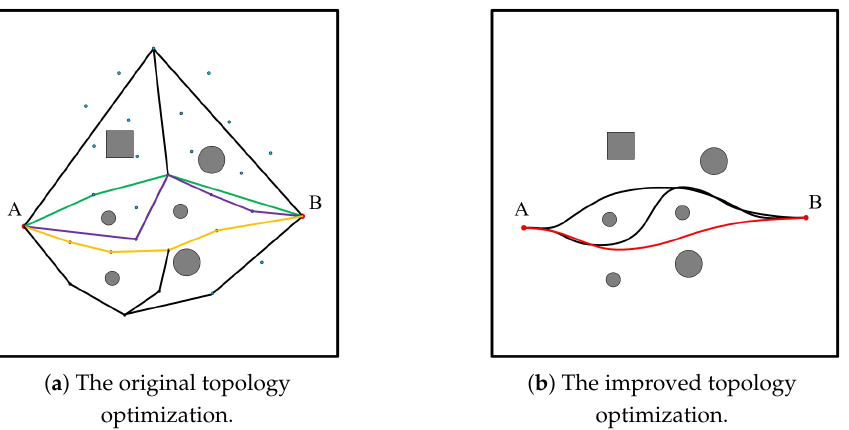
Figure 5. The topology optimization of the improved two-step TEB. A denotes the start point, and B denotes the goal point.The original TEB in ( a ) selects the top n ; there are three paths from all sampled paths. The improved two-step TEB in ( b ) chooses the only optimal path after speed